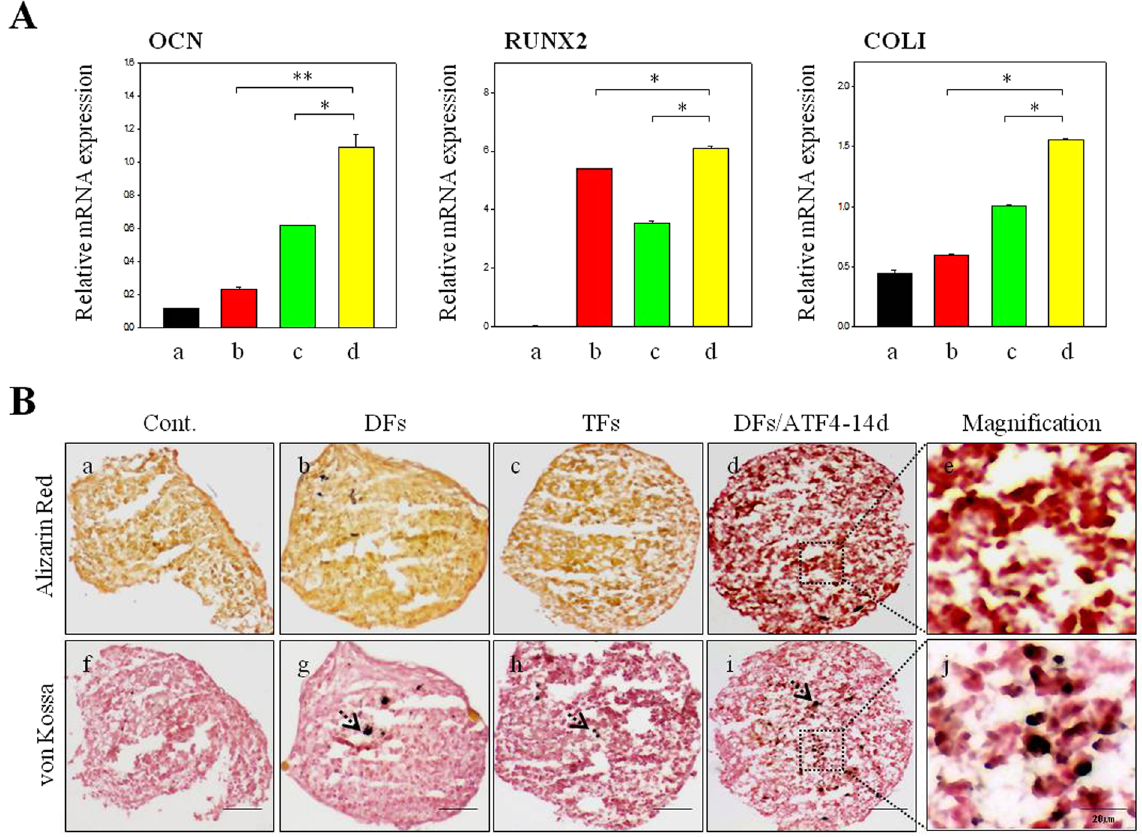
Figure 7. Osteogenesis of hMSCs transfected with two and three genes in a 3D culture system. ( A ) qPCR analysis of OCN, RUNX2, and COL1A2 mRNA levels in hMSCs transfected with two and three genes. * P < 0.05, ** P < 0.01. ( B ) Histological analysis of osteogenesis. (a–e) Alizarin Red S staining and (f–j) von Kossa staining. (a and f) control; (b and g) hMSCs transfected with two genes; (c and h) hMSCs transfected with three genes at the same time point; (d and i) hMSCs transfected with ATF4 at 14 days after RUNX2/SP7; (e and j) magnifications of the images shown in panels (d and i). Scale bar, 200 μ